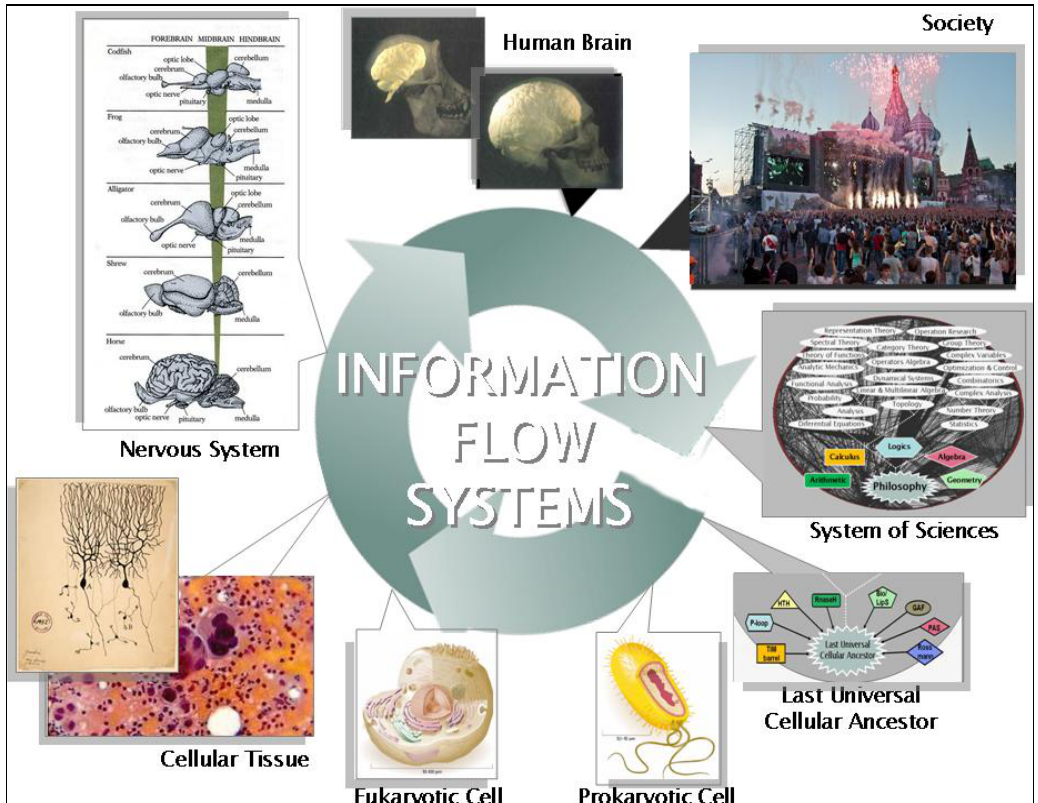
Figure 5. Information Flow Systems: a visual